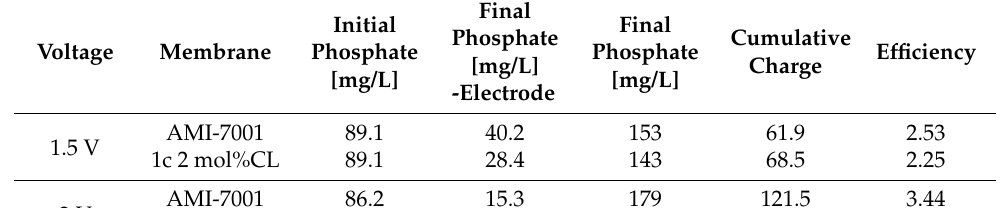
Table 2. Phosphate removal from aerated swine WW by electrodialysis.